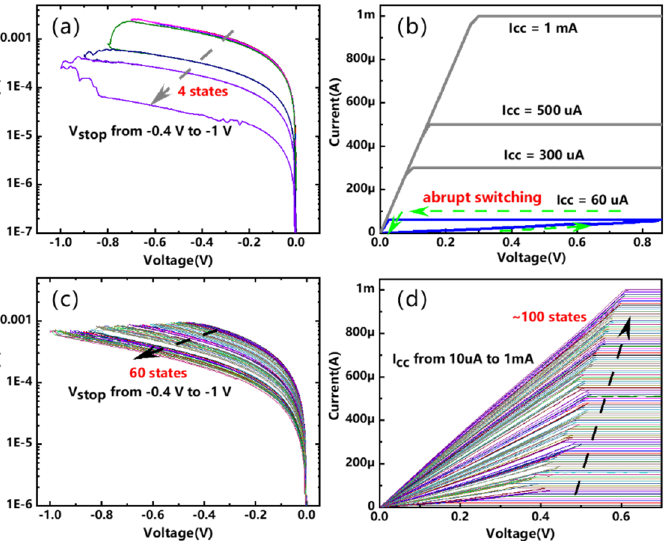
Figure 6. Comparison of DC analog characteristics for Pt/TaO x /TiN RRAM and Pt/TaO x :Al/TiN RRAM. ( a ) Gradual reset process of Pt/TaO x /TiN RRAM. Four states can be obtained with reset stop voltage increasing from − 0.4 V to − 1 V with a step of − 0.1 V. ( b ) Abrupt set process of Pt/TaO x /TiN RRAM. The undoped device has been tuned by increasing set CC repeatedly, and representative I-V curves with set CC (60 uA, 300 uA, 500 uA and 1 mA) are shown here for the sake of illustration. An obvious switching window appears at 60 uA CC, and the device cannot be tuned gradually to LRS, with CC increasing to 1 mA. Over 150 resistance states can be achieved in Pt/TaO x :Al/TiN RRAM through ( c ) increasing reset stop voltage from − 0.4 V to − 1 V with a step of − 0.01 V and ( d ) increasing CC gradually from 10 uA to 1 mA with a step of 10 uA.